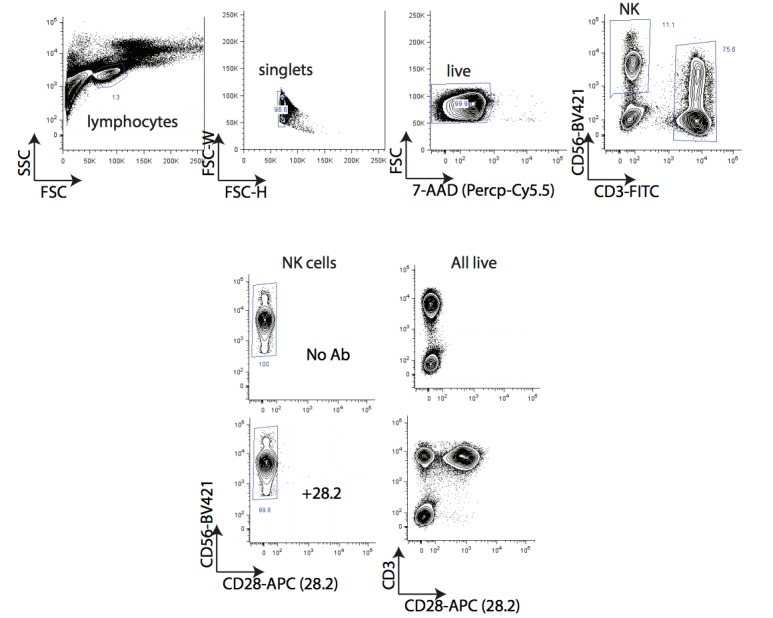
CD28 expression in untouched PBMCs.